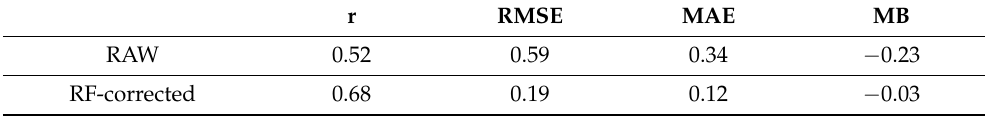
Table 2. Correlation and residuals of AOD estimations for the year 2021 against MODIS Terra observation. The raw AODs are CHIMERE outputs at 10:00 LT and for the corrected AOD with the RF model (trained with MODIS AQUA observations at 13:30 LT). Number of data points is 3.7 million. r RMSE RAW